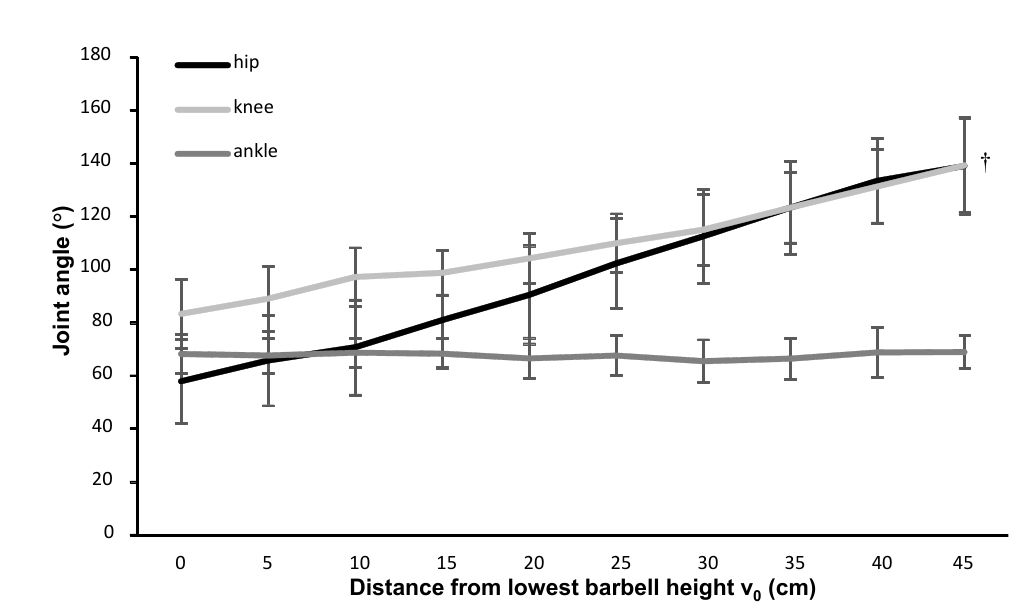
Figure 4. Mean ( ± standard deviation) joint angles of hip extension, knee extension, and ankle dorsal flexion at different vertical distances from the lowest barbell position in the isometric contractions. † Indicates a significant difference ( p < 0.05) in joint angle between each adjacent height for knee and hip extension.